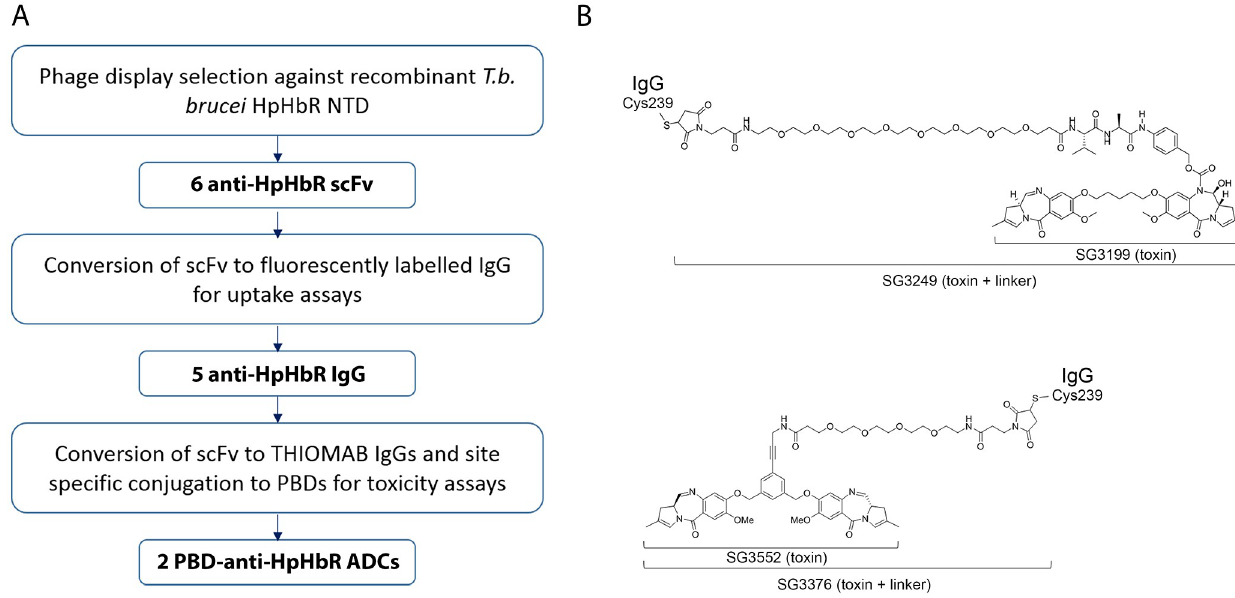
Fig 1. The generation of ADCs that target the T . brucei HpHbR. (A) Workflow for the generation of anti-trypanosomal ADCs. (B) Structures of the two PBD toxins (SG3199 and SG3552) and their corresponding toxins plus linker derivatives (SG3249 and SG3376) used in this study. Note that the linker of SG3249 contains a cleavable dipeptide motif whereas the linker of SG3376 does not.